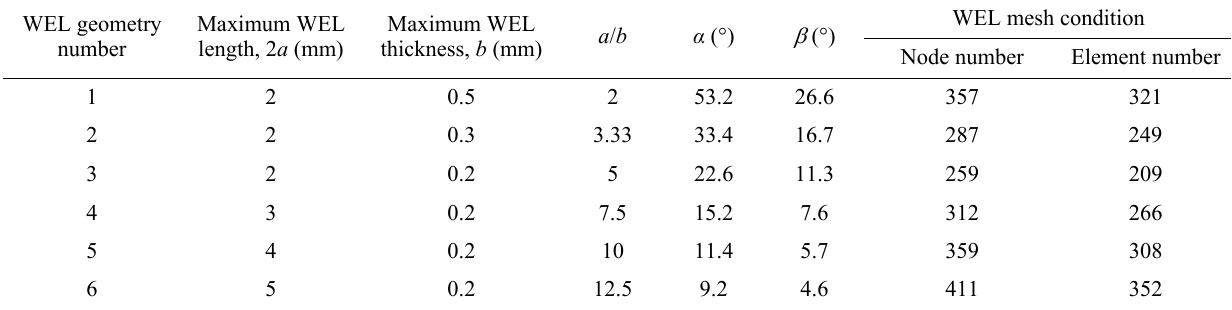
Table 2 Detailed parameters of the WEL geometry model and mesh conditions used in the simulations.